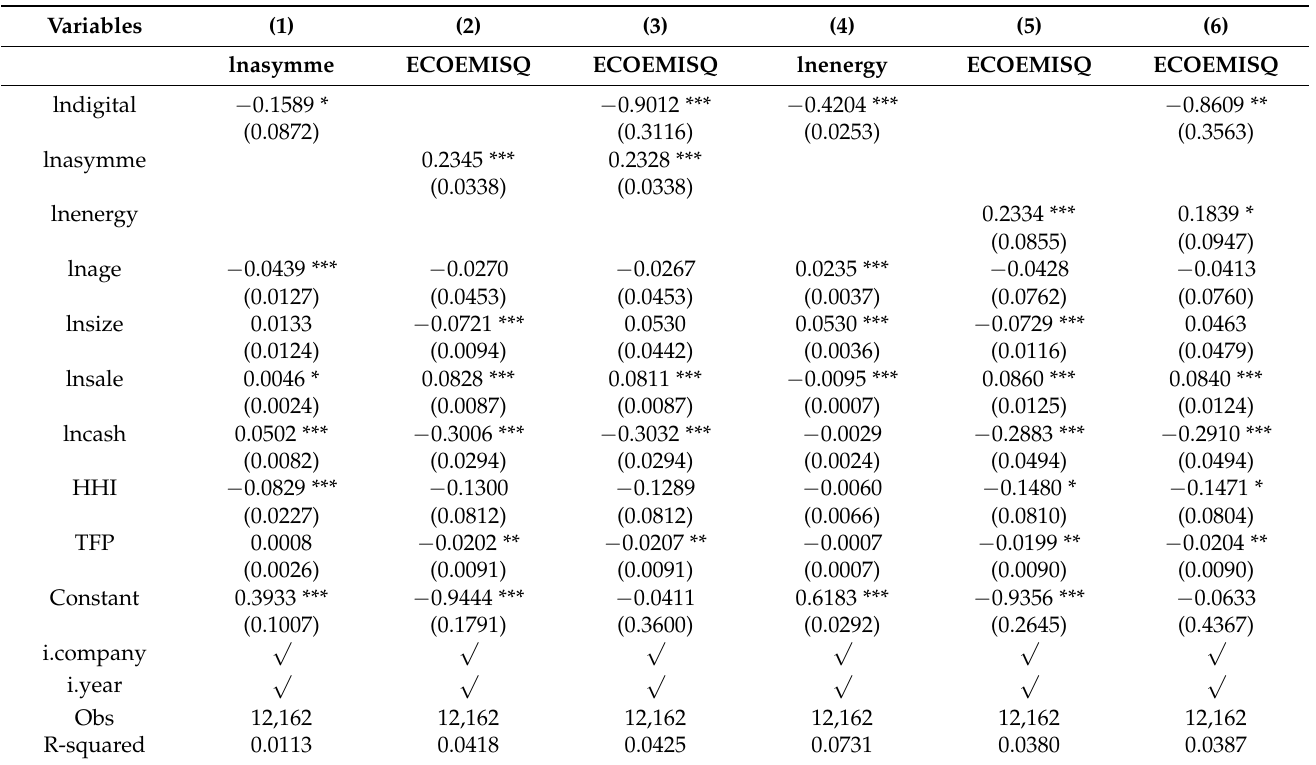
Table 9. Information asymmetry and energy